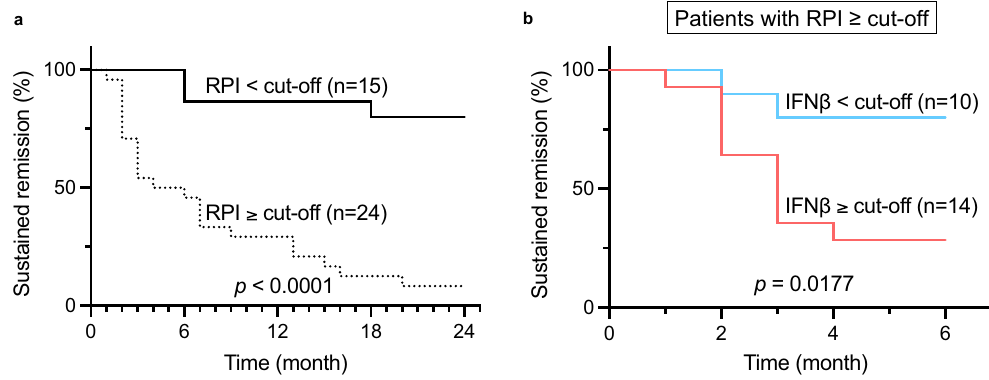
Figure 4. Kaplan–Meier survival curves displaying early relapse estimates in RPI score-positive patients, stratified by IFNβ cut-off value from ROC curves. ( a ) Kaplan–Meier curves for 24-month survival, stratified by the RPI cut-off value of samples at the study initiation point (t1). The solid or dotted graph line represents a group with a low RPI score (n = 15), which predicts sustained remission, or a group with a high RPI score (n = 24), which predicts relapse. ( b ) Kaplan–Meier curves for the first 6 months of survival, stratified by IFNβ cut-off value in a group with a high RPI score. The cyan or orange-red graph line represents groups of low IFNβ score (n = 10) or high IFNβ score (n = 14), respectively. The log-rank test was used to calculate the p value . The images were created using GraphPad Prism 9 (www. graph pad.